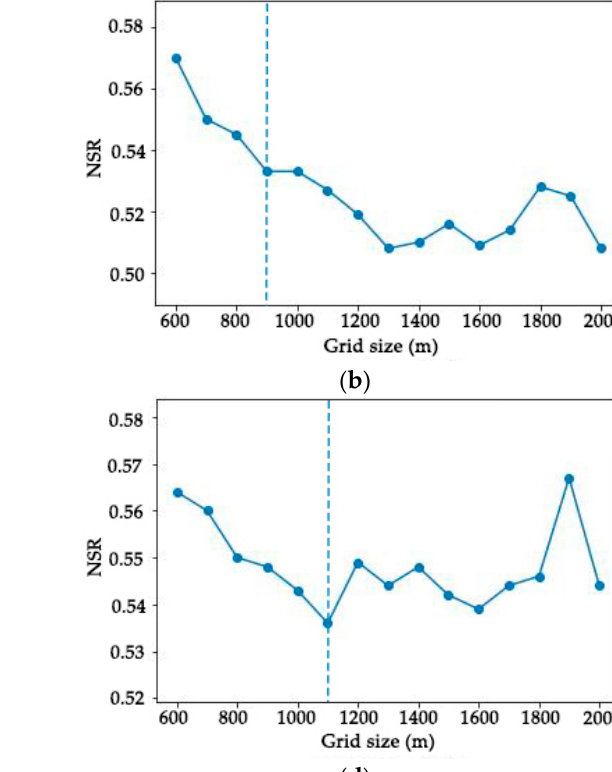
Figure 7. Comparison of 90% quantile of q values for explanatory variables under different grid sizes.